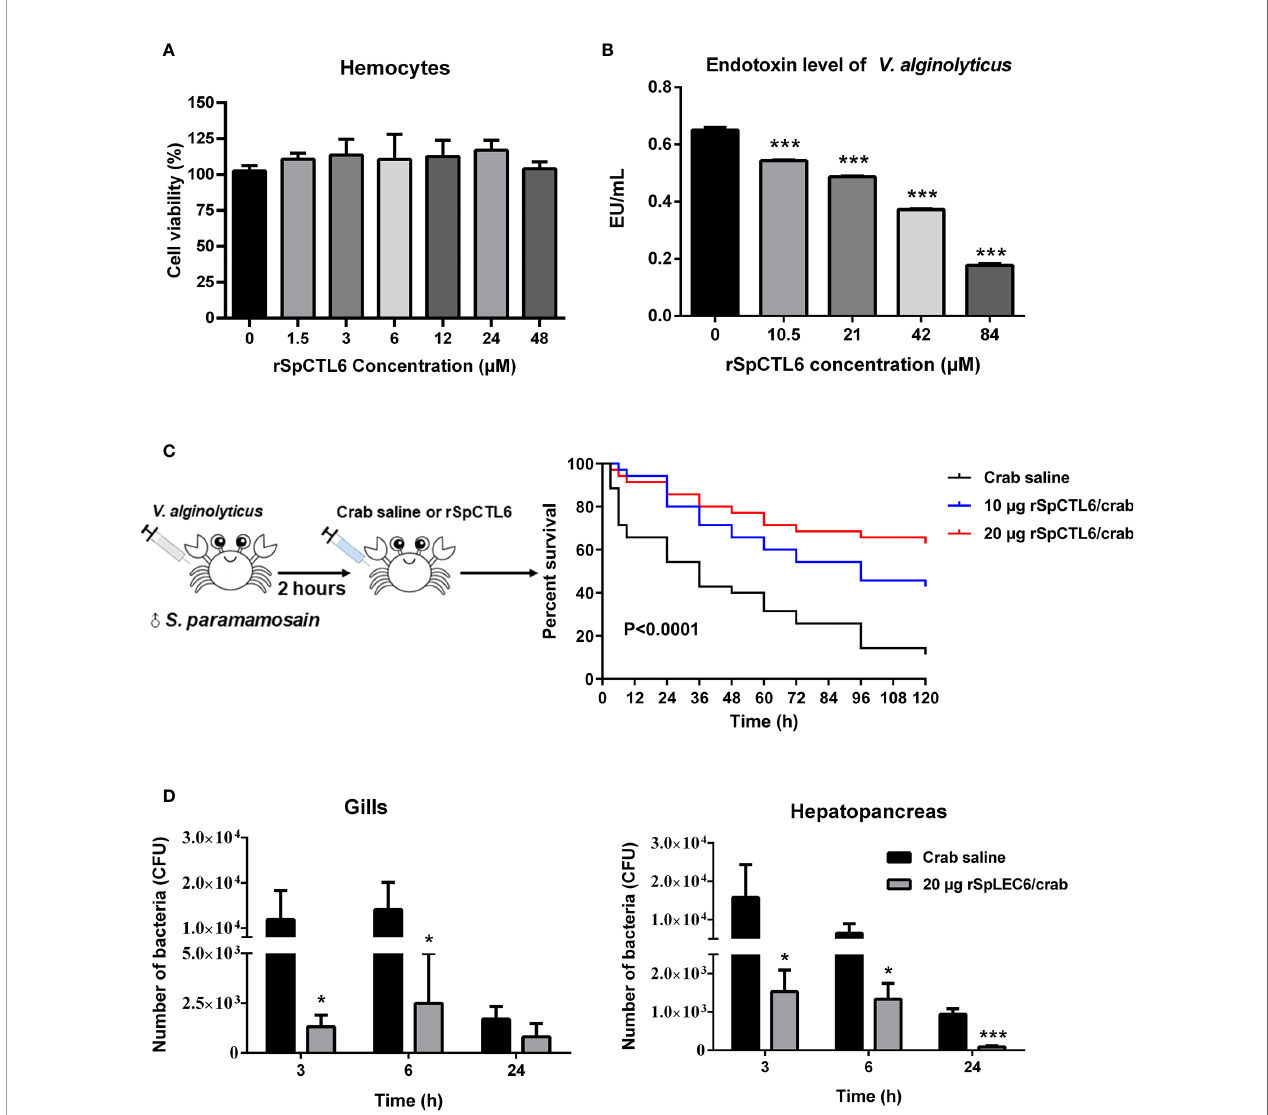
FIGURE 6 | Evaluation of cytotoxicity and endotoxin level of V. alginolyticus after rSpCTL6 treatment in vitro and the immunoprotective effect of rSpCTL6 in S. paramamosain . Cytotoxic effect of rSpCTL6 on crab hemocytes (A) and endotoxin level of V. alginolyticus after rSpCTL6 treatment in vitro (B) . The survival curve of mud crabs after rSpCTL6 treatment (C) . Male crabs were challenged with V. alginolyticus , and SpCTL6 was injected (10 m g crab -1 or 20 m g crab -1 ) at 2 h post bacterial challenge (n=35). Bacterial clearance of V. alginolyticus in the gills and hepatopancreas (D) . The bacterial burden in the gills and hepatopancreas were determined at 3, 6 and 24 hpi. * represented p < 0.05 and *** represented p <